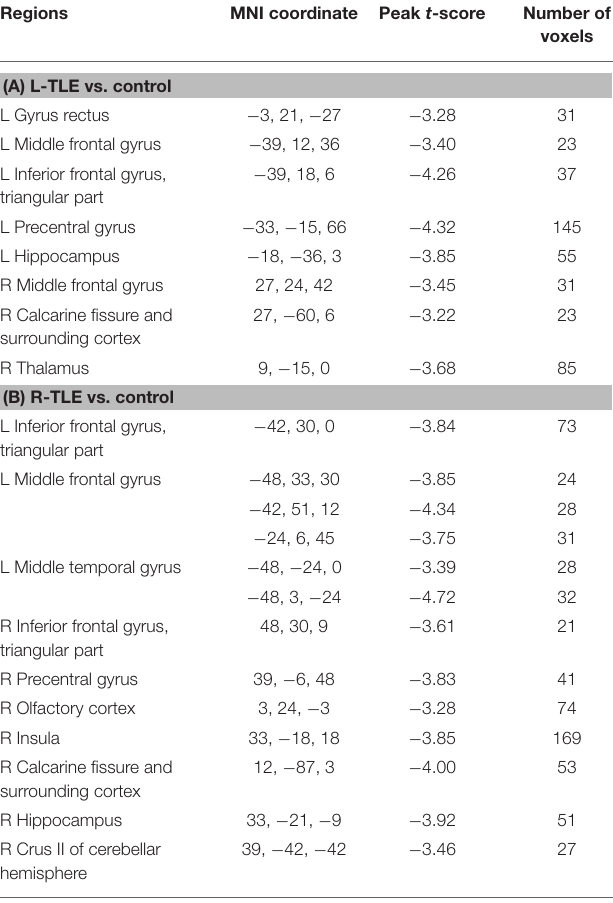
TABLE 5 | The cortical regions with gray matter density that was significantly related to the seizure duration in (A) L-TLE and (B) R-TLE.